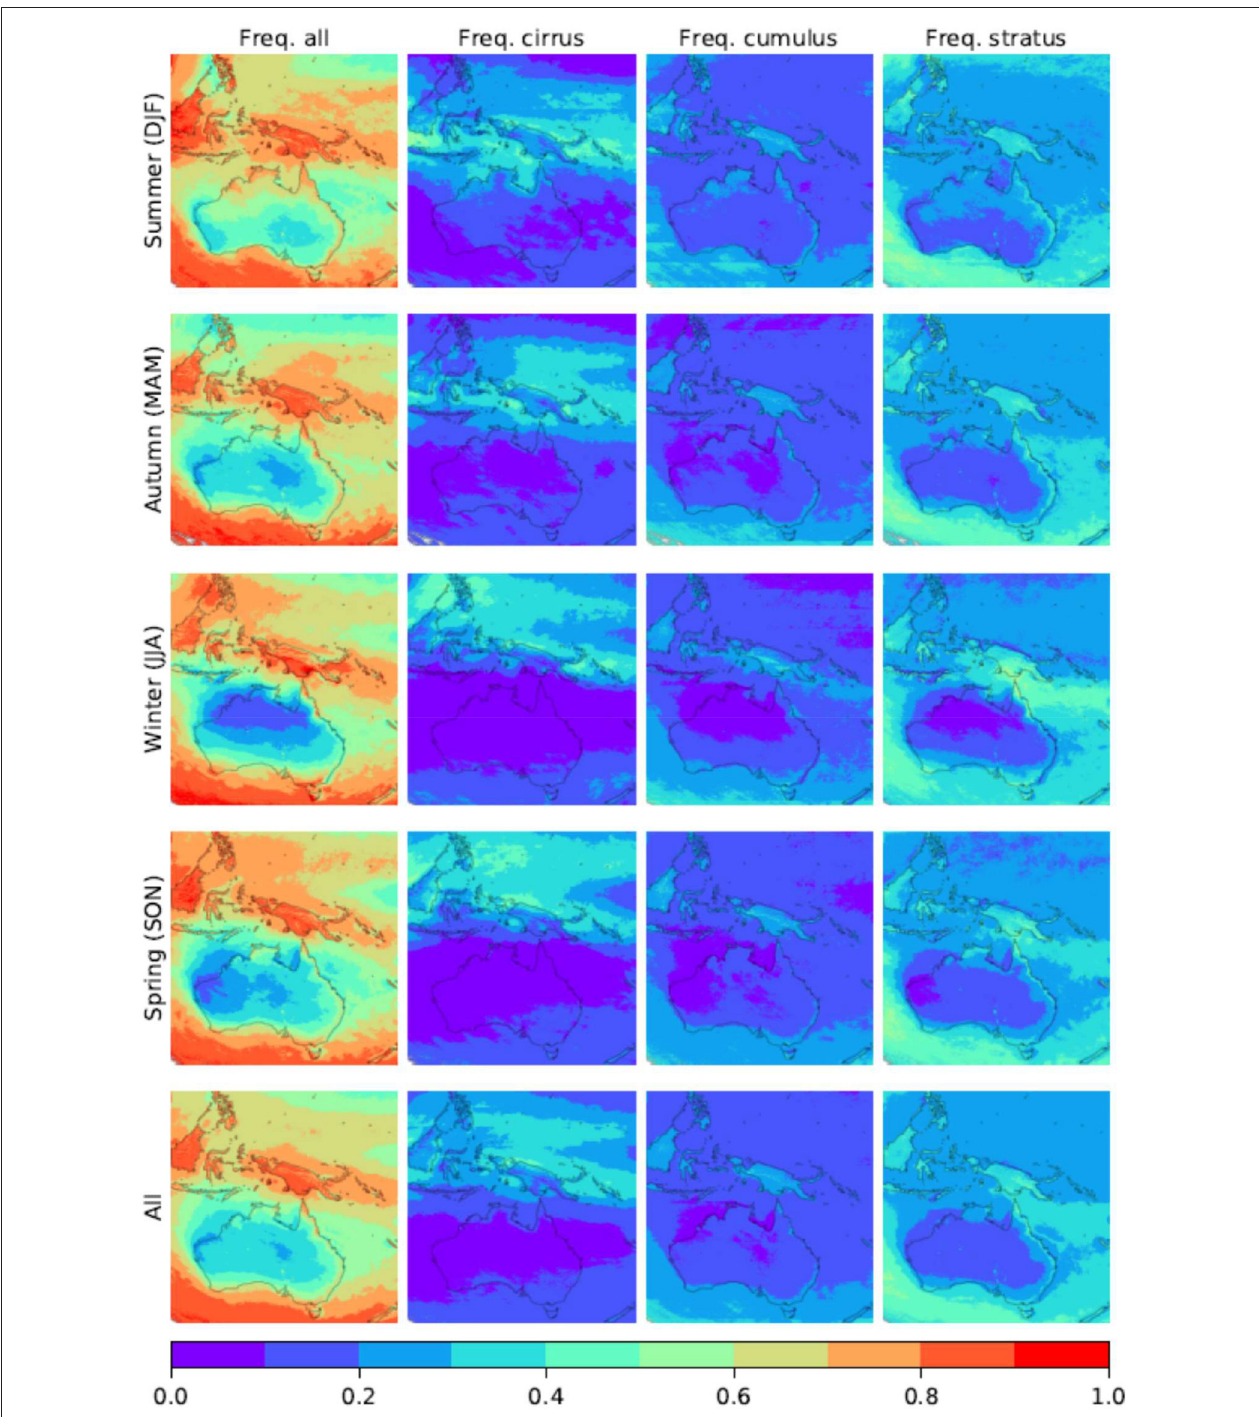
FIGURE 14 | The left-most column (denoted column 1 here) shows cloud frequency for the all cloud types with columns 2–4 (from left to right) show the frequency of the broad cloud types. The austral seasons are provided in rows 1–4 and the yearly mean is given in row 5. Data obtained for the period from 1 Jan 2016 to 30 Nov 2017 for daylight hours from 22UTC to 8UTC (8–18 Australian east standard